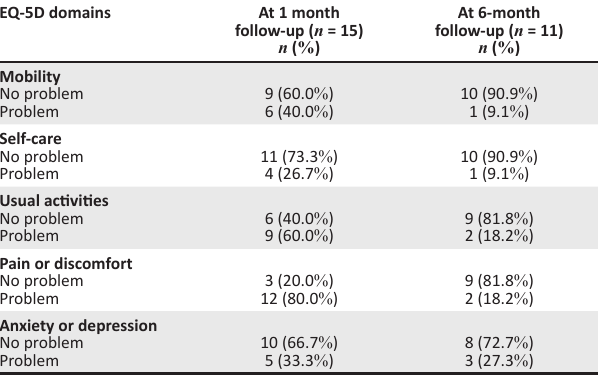
TABLE 5: Response frequencies for categorical data obtained for the various domains of the EuroQol Group 5 Dimension. EQ-5D domains